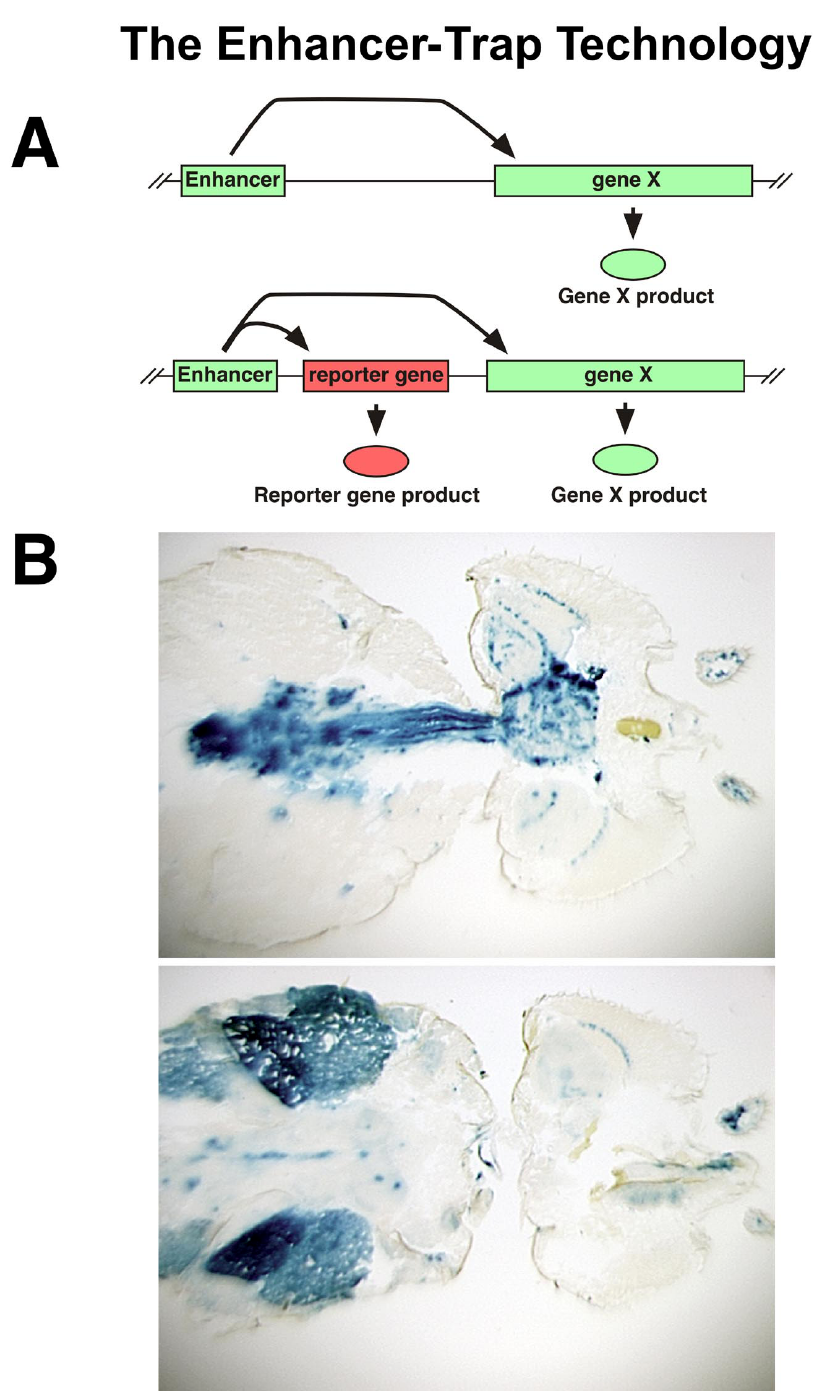
FIGURE 1. The enhancer-trap technique. (A) Somewhere in the genome, the expression of the gene X is controlled by a regulatory element called the enhancer. In the enhancer-trap technique an engineered piece of DNA that includes a reporter gene is inserted near the gene X enhancer. As a consequence, the enhancer also controls the reporter gene. The reporter gene product can be measured to provide quantitative data about the enhancer activity. (B) The reporter gene product can also be revealed in situ to reveal the tissue- specificity of the enhancer. The figures show two enhancers with different tissue specificity at 50 days old (top, nervous system; bottom, muscles). From L. Seroude,